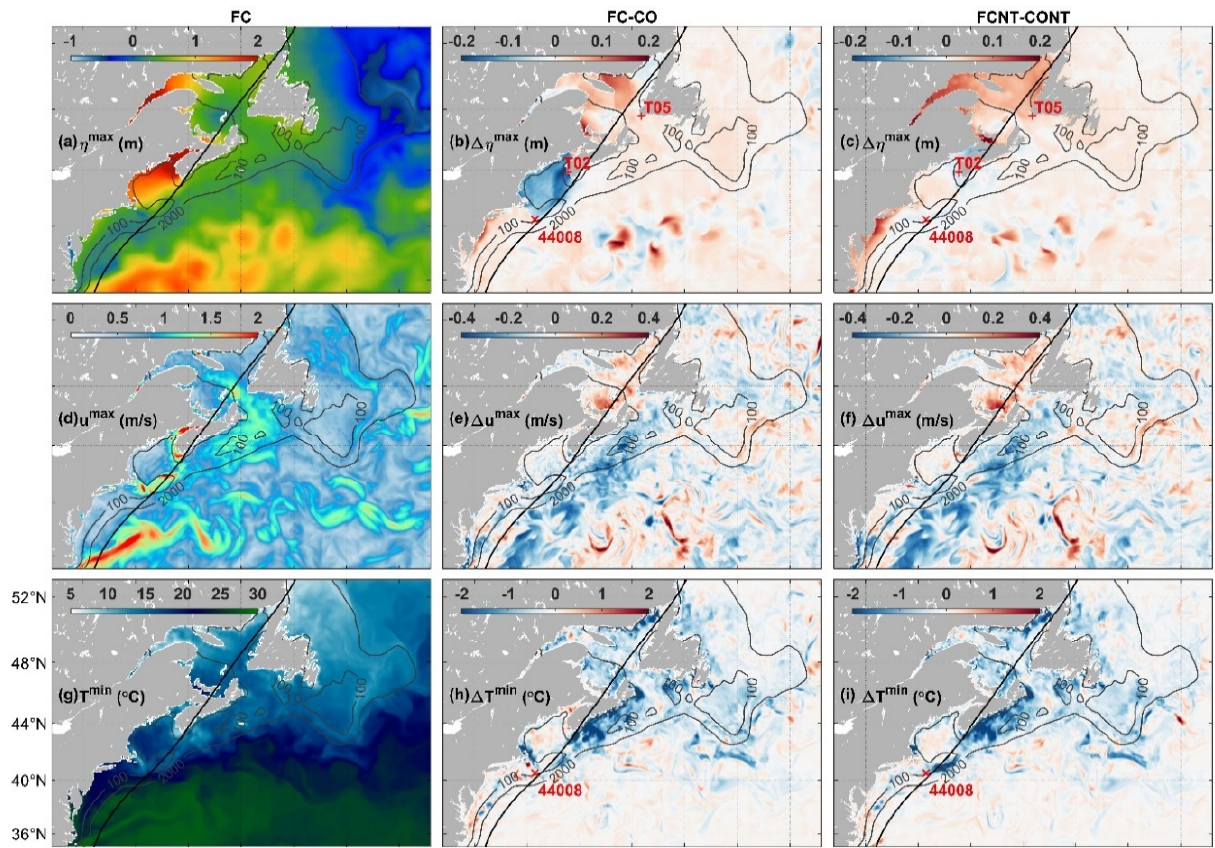
Figure 10. Swath maps of the ( a ) maximum surface elevations, ( d ) maximum surface currents, and ( g ) minimum sea surface temperature in run FC during the study period and the corresponding differences ( b , e , h ) between runs FC and CO and ( c , f , i ) between runs FCNT and CONT. The black line represents the storm track.